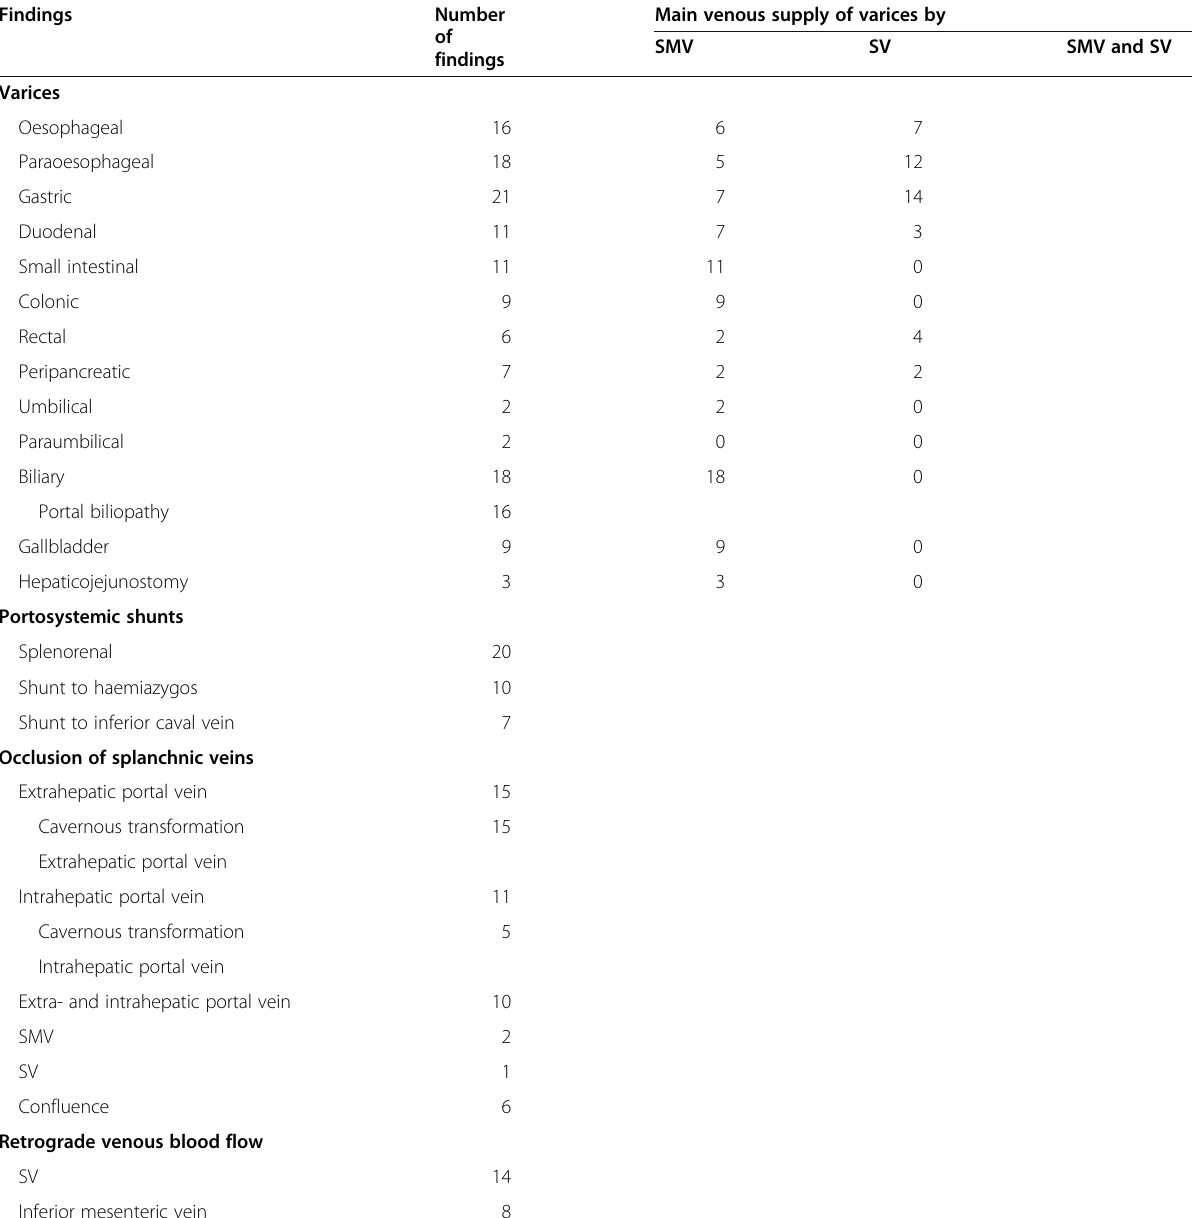
Table 1 Haemodynamic changes in 22 children with portal hypertension detected by sequential computed tomography arterioportography-arteriosplenography